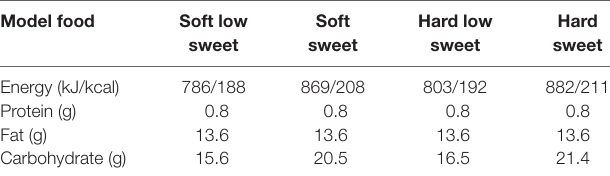
Table 1 | Energy and macronutrient content of the model foods per 100 g.